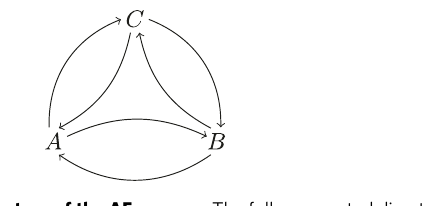
Fig. 5 The causal structure of the AF process. The fully connected directed graph with three nodes A , B and C